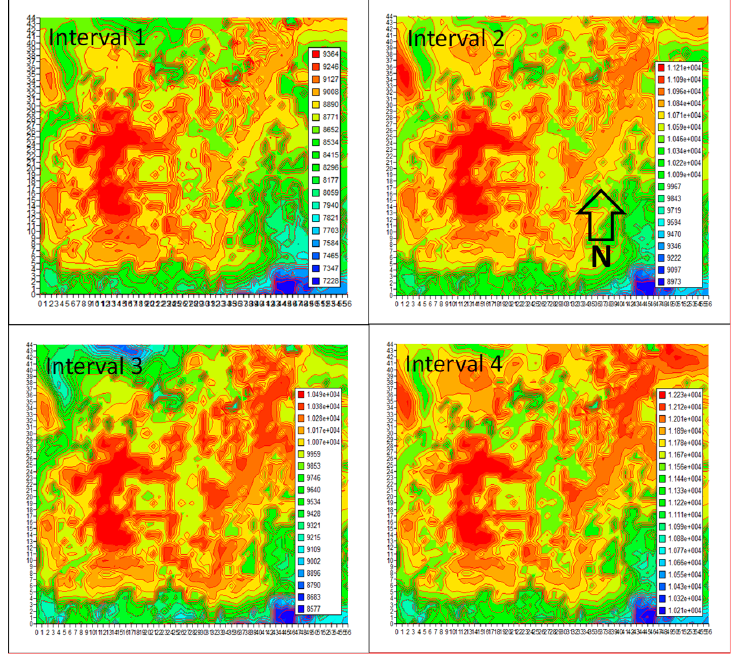
Figure 7. Modeled total degree-hours (DH) for intervals 1–4 in the San Fernando Valley domain. The derived interval-average temperature (computed as DH/hour), blue to red, is as follows: 17.7–22.9 °C for interval 1; 22.0–27.5 °C for interval 2; 21.0–25.7 °C for interval 3; and 23.6–30.0 °C for interval 4.